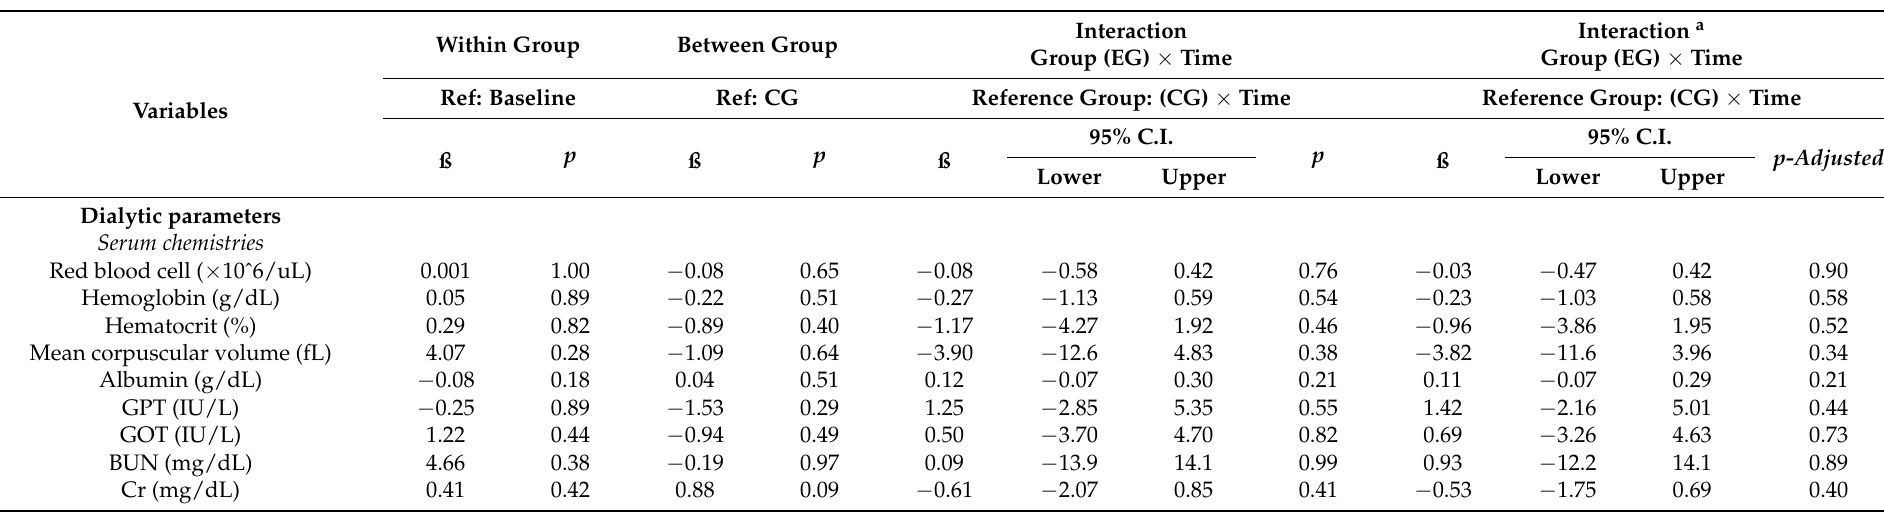
Table 3. Evaluation of the intervention on dialytic parameters, health-related quality of life, and depression status based on the GEE